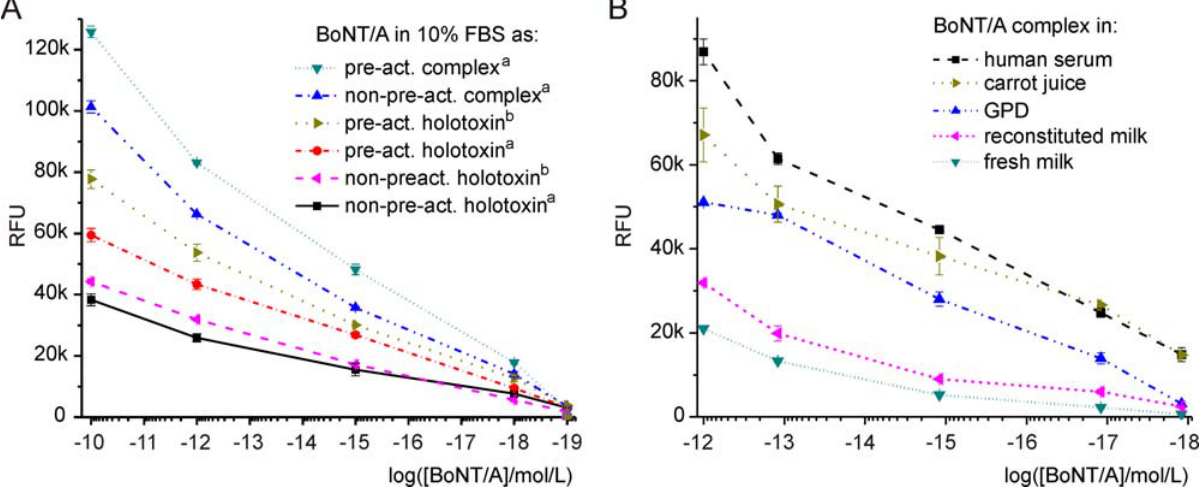
Figure 3. Sensitivities of BoNT/A ALISSA. BoNT/A detection in (A) 10% fetal bovine serum (FBS) to various forms and sources of the toxin; a Metabiologics (Madison, WI) and b List Biological Laboratories (Campbell, CA); (B) in undiluted human serum, 50% carrot juice (with binding buffer), gelatin phosphate diluent (GPD), reconstituted powdered milk (fat free) and fresh whole milk (2% fat). Pre-act.=toxin preactivated with 5 mM DTT; all reactions with SNAPtide were carried out with 1.25 mM DTT.